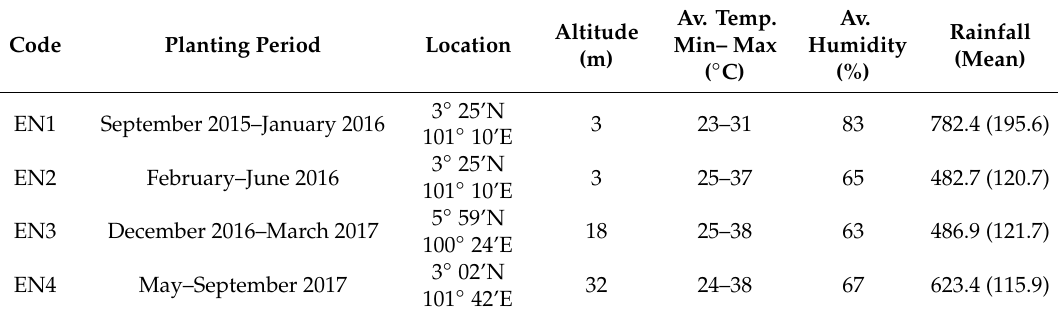
Table 1. Environmental data and